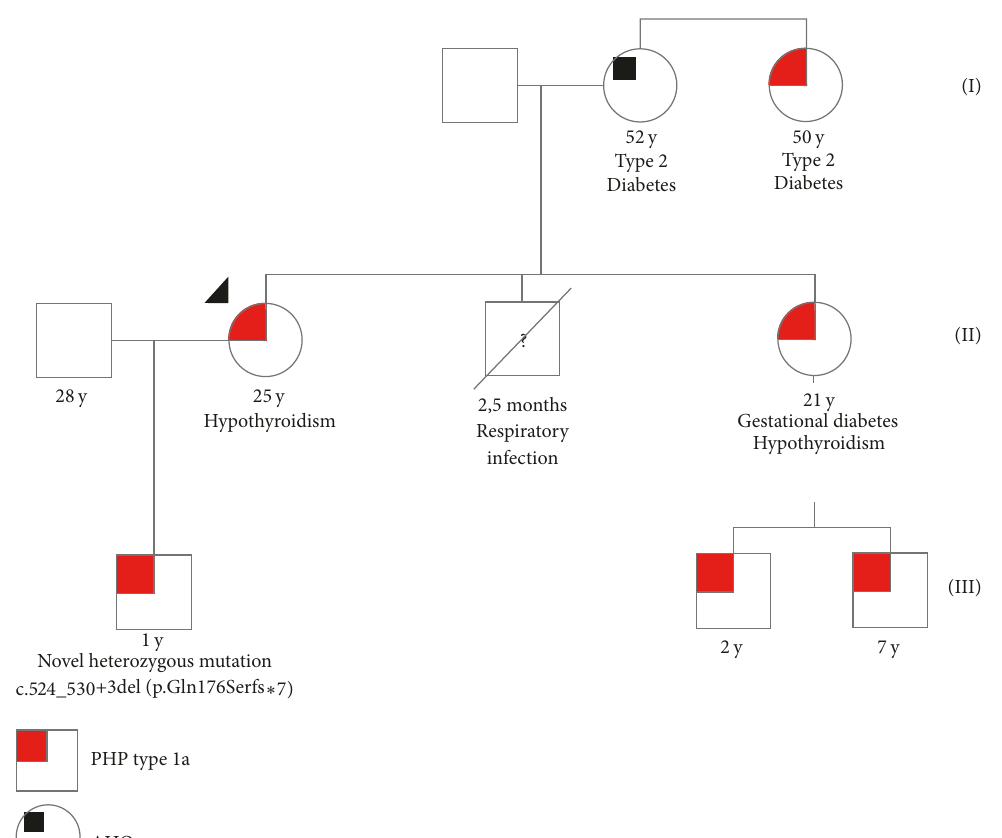
Figure3:Genogramofthesubject’sfamily. Oursubjectisidentifiedbytheblackarrow-head. y:year(s)old;PHP:pseudohypoparathyroidism; AHO: Albright’s hereditary